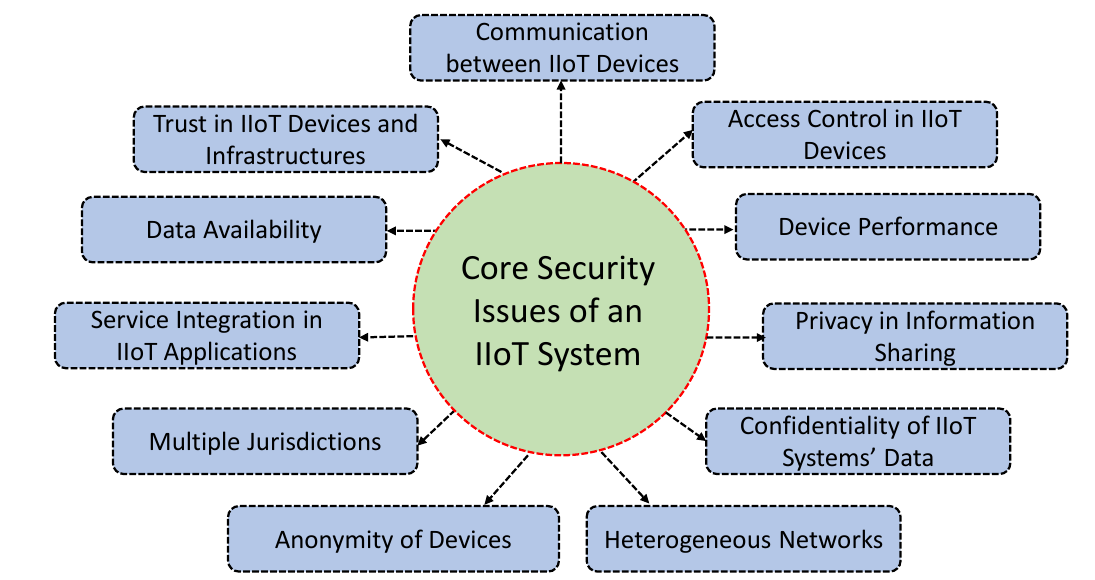
Figure 5. Outline of the core security issues in an IIoT